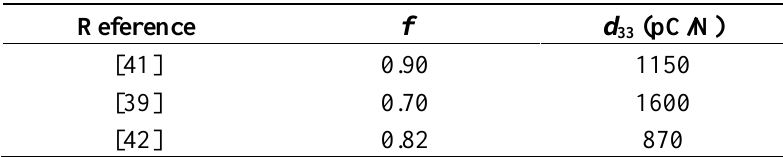
Table 3. Observed piezoelectric charge coefficients d phase boundary